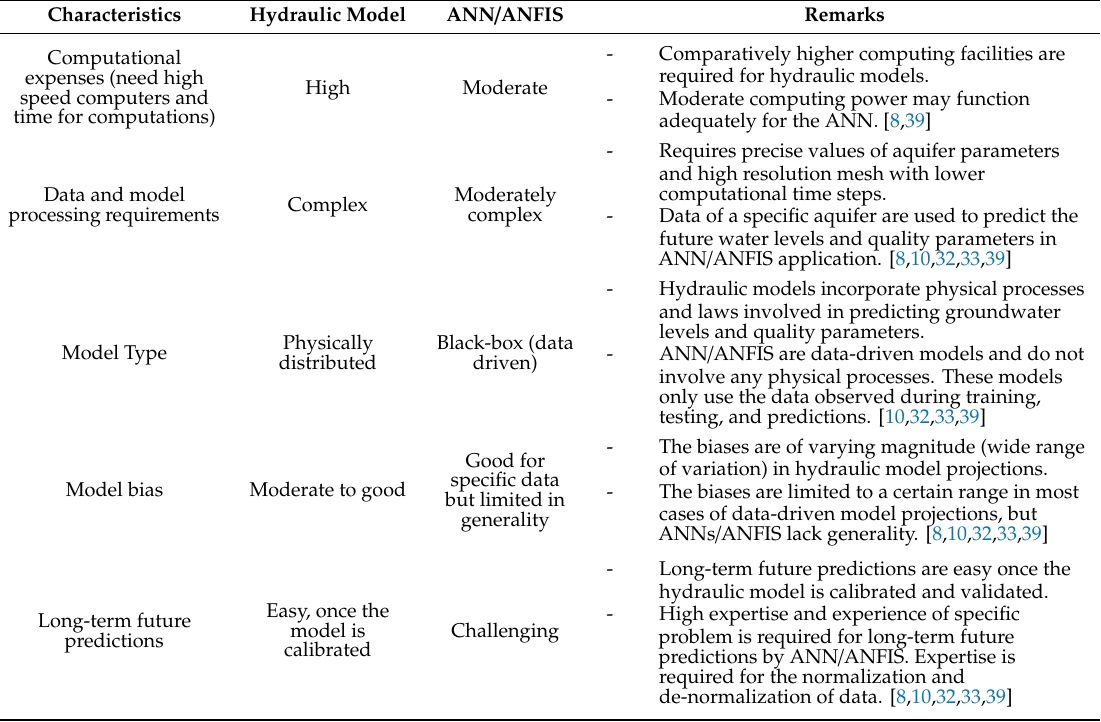
Table 1. Comparison of GCM with data-driven models ANN and